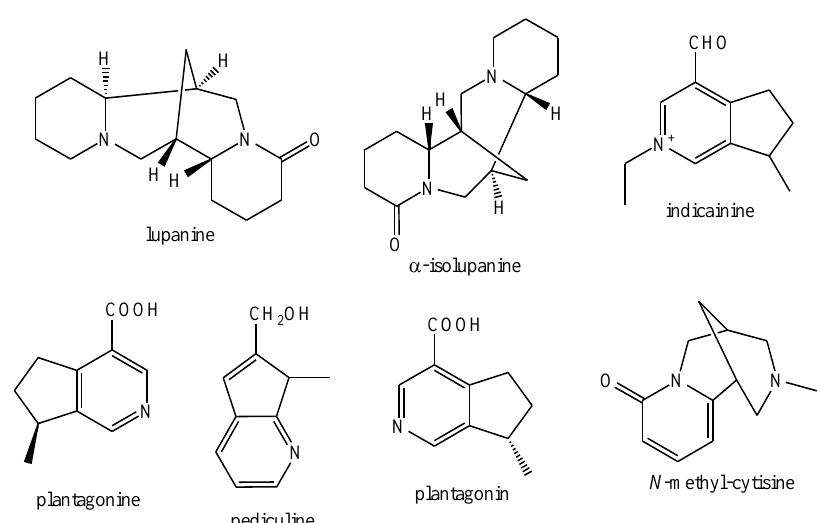
Figure 4. Terpenoids identified in Pedicularis species.